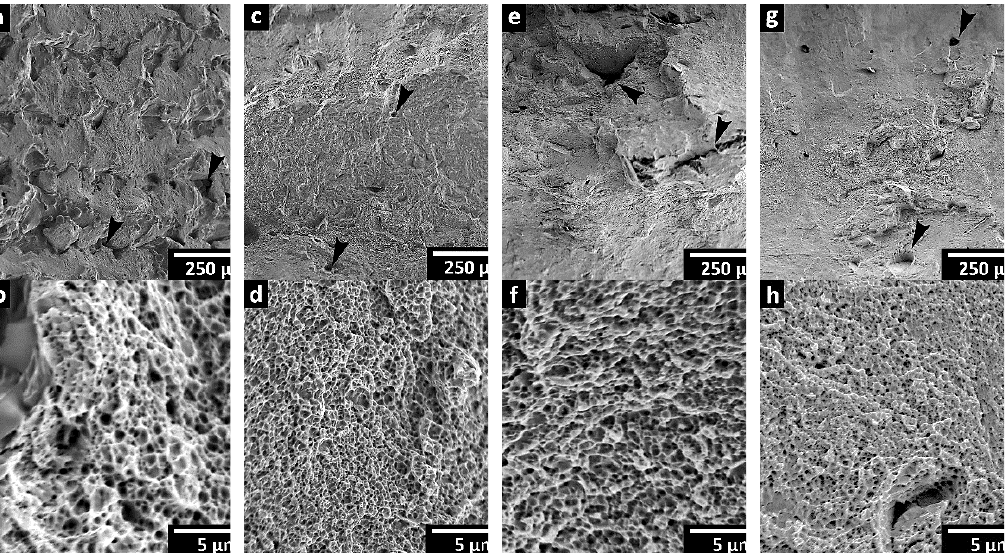
Figure 13. SEM fractographs showing the tensile fracture surfaces of as-built 316LSS produced at: ( a , b ) 160 W, ( c , d ) 240 W, ( e , f ) 320 W, and ( g , h ) 380 W.